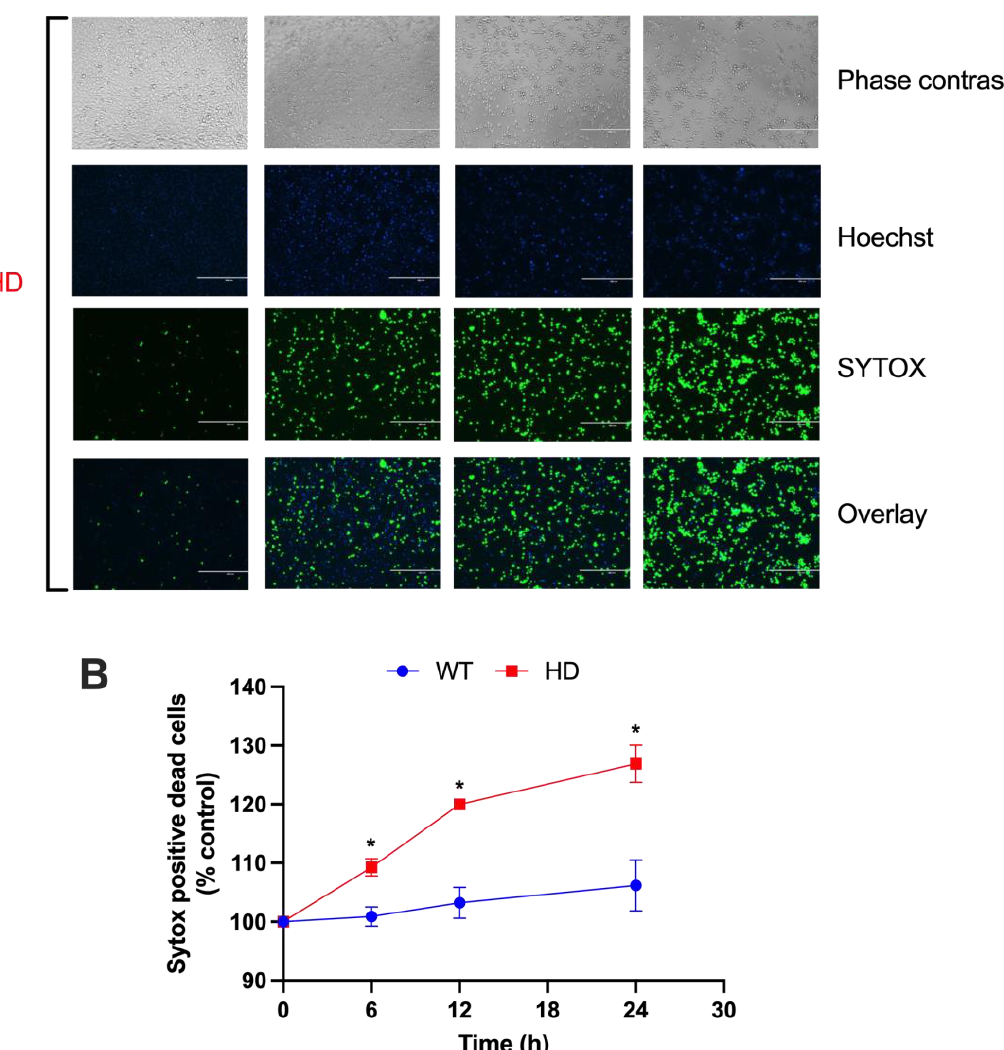
Figure 1. HD striatal cells are more sensitive to Cd-induced cell death compared with WT. ( A ) Rep- resentative qualitative images and ( B ) quantitative analyses of cell death in WT and HD cells after exposure to 40 µ M CdCl 2 were examined at 0, 6, 12, and 24 h using an SYTOX Green cell death assay and Hoechst DNA stain. Cell death is expressed as the percentage of the respective vehicle. Results are represented by the mean ± SEM from four biological replicates (N = 4). Sidak’s multiple comparison test compared the effect of Cd-induced cell death between genotypes at the indicated time points (* p < 0.01). Images at 10 ×